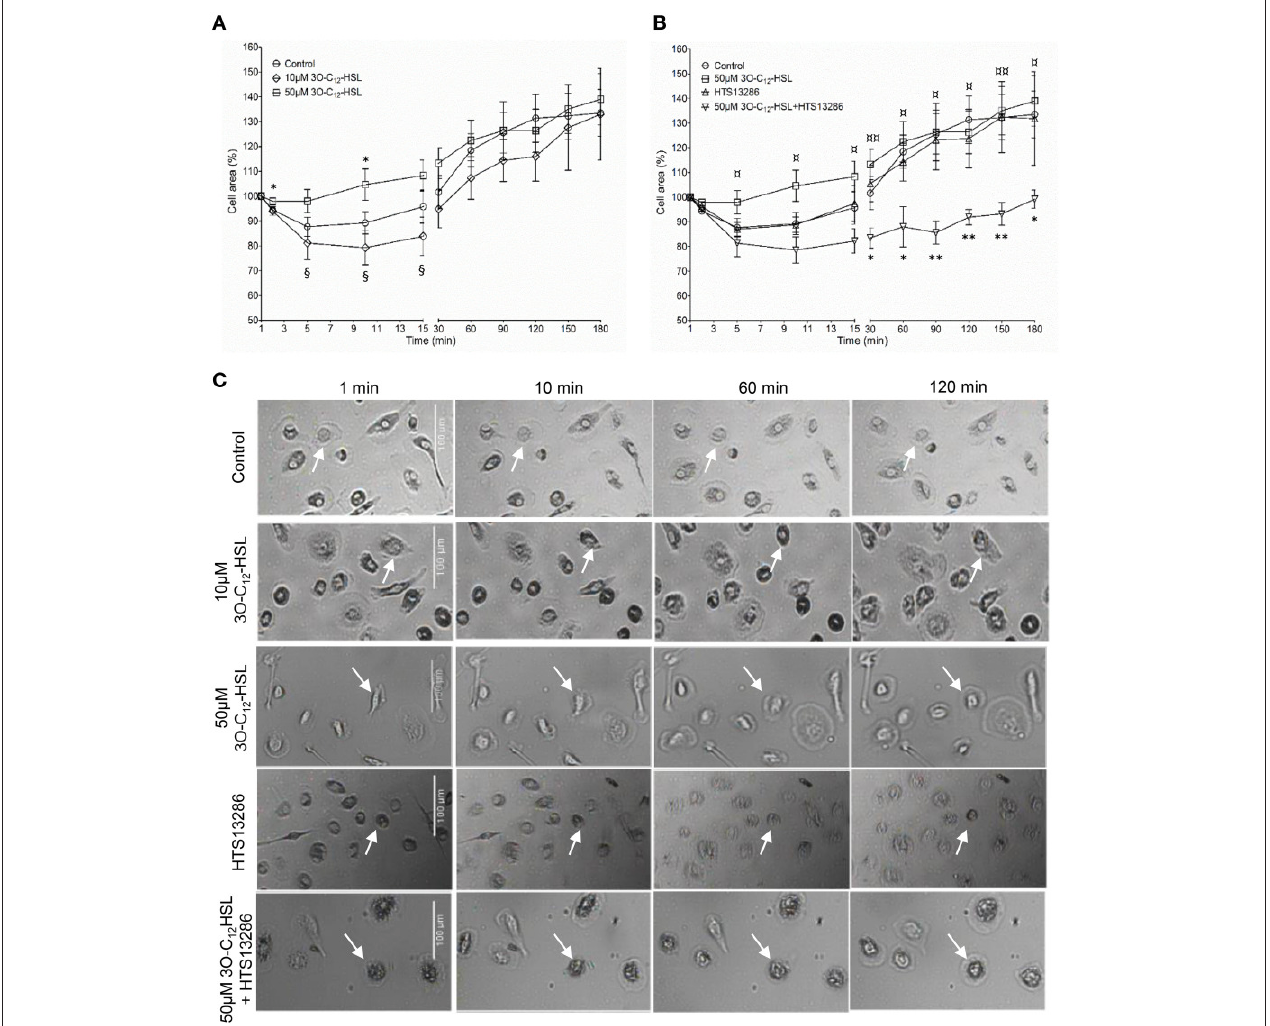
FIGURE 1 | Live 2D imaging of cell area and protrusive activity in 3O-C 12 -HSL-stimulated macrophages. (A) Macrophages were treated either with 0.02% DMSO (Control), or 10 and 50 µ M 3O-C 12 -HSL. (B) Cells were treated with 50 µ M 3O-C 12 -HSL, 25 µ M HTS13286, or simultaneously with both 50 µ M 3O-C 12 -HSL and 25 µ M HTS13286, or 0.27% DMSO (not shown) or 0.02% DMSO as a vehicle control (Control). Control groups and 50 µ M 3O-C 12 -HSL groups were the same in (A) and (B) . A time-lapse Videos S1 – S5 were recorded using JULI and cell area was quantified and shown as percent (%) change relative to the initial area. Values are the mean ± SE ( n = 8 for Control and 50 µ M 3O-C 12 -HSL; n = 3 for 10 µ M 3O-C 12 -HSL; n = 4 for 25 µ M HTS13286; and 50 µ M 3O-C 12 -HSL + 25 µ M HTS13286) based on at least 20 cells for each condition and experiment. Significant differences were analyzed by one-tailed, un-paired Student’s t -test and are indicated with * or ** when P < 0.05 or P < 0.01 compared to control, with ¤or ¤¤when P < 0.05 or P < 0.01 comparing 50 µ M 3O-C 12 -HSL and 50 µ M